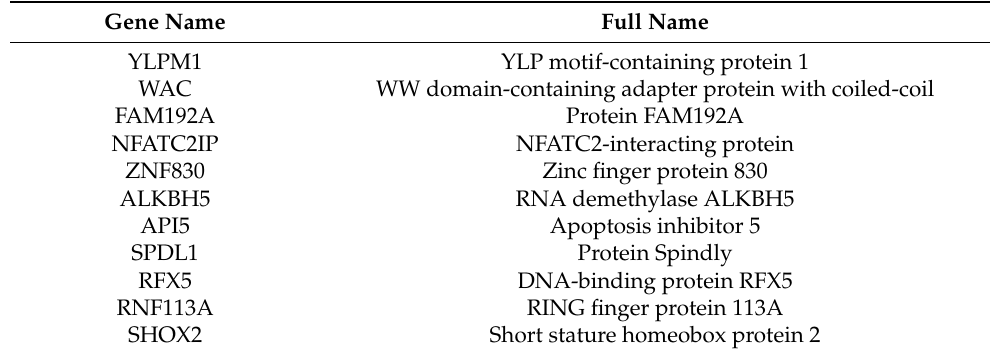
Table 3. List of Ku70 vWA-specific candidate protein interactors that appeared in three biological replicates of Ku70 vWA-BioID2. Final Ku70 vWA candidates are shared with full-length Ku70 results and absent from the Ku70 ∆ vWA protein candidates list. Final candidates were filtered using the negative control cell lines, HEK293 and